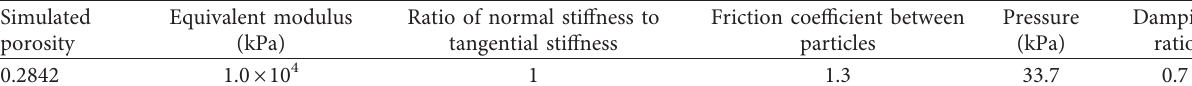
Table 5: Physical parameters of compaction test numerical simulation.